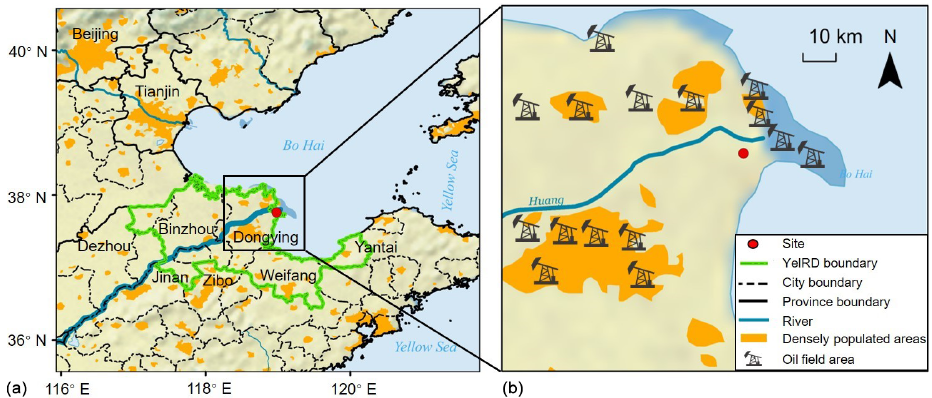
Figure 1. Map showing the location of the Yellow River delta. Panel (b) shows the surroundings of the sampling site and the approximate positions of the oil field areas (base map: made with Natural